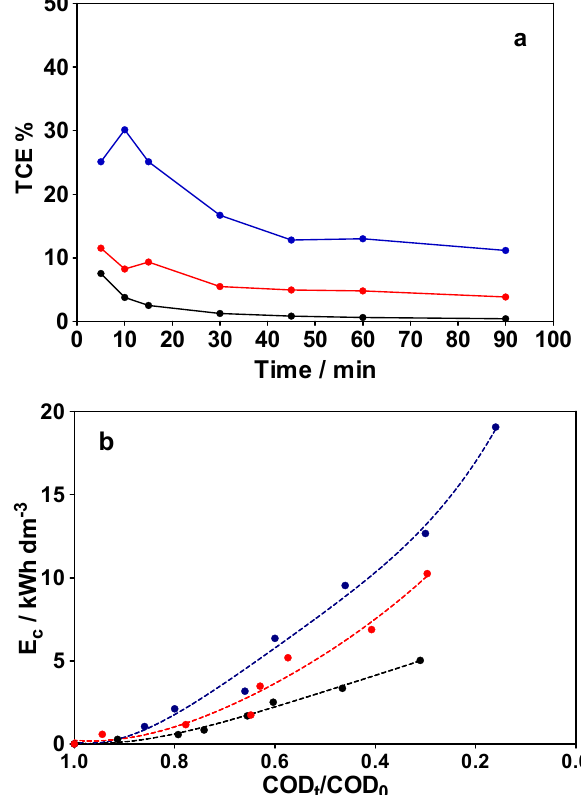
Figure 5. ( a ) Total current efficiency (%TCE) over time and ( b ) energy consumption (EC) as a function of COD removal, during the treatment of a solution containing HCQ (26.8 mg L − 1 ) at different current densities ( • ) 15, ( • ) 30 and ( • ) 45 mA cm − 2 on the abatement of 26.8 mg L − 1 of HCQ in a 0.1 M H 2 SO 4 solution.